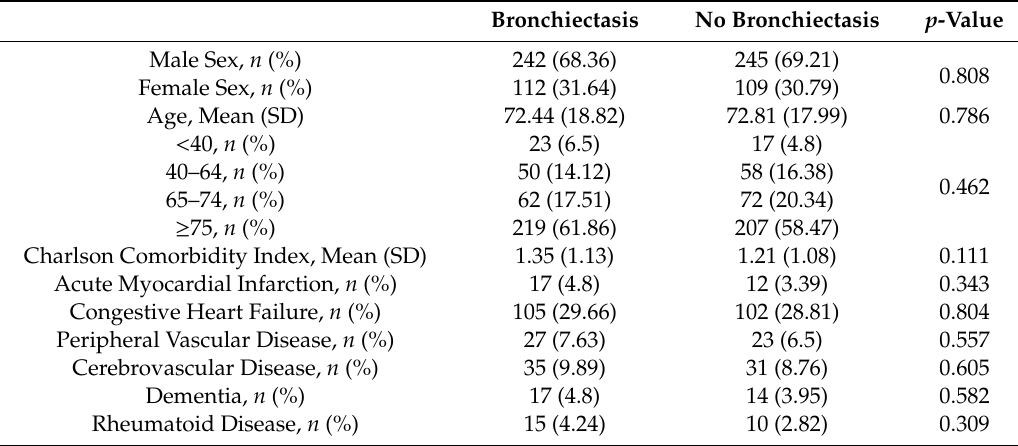
Table 3. Distribution of study variables and hospital outcomes of patients with and without bronchiectasis hospitalized with non-ventilator hospital-acquired pneumonia (NV-HAP) in Spain (2016-17), after propensity score